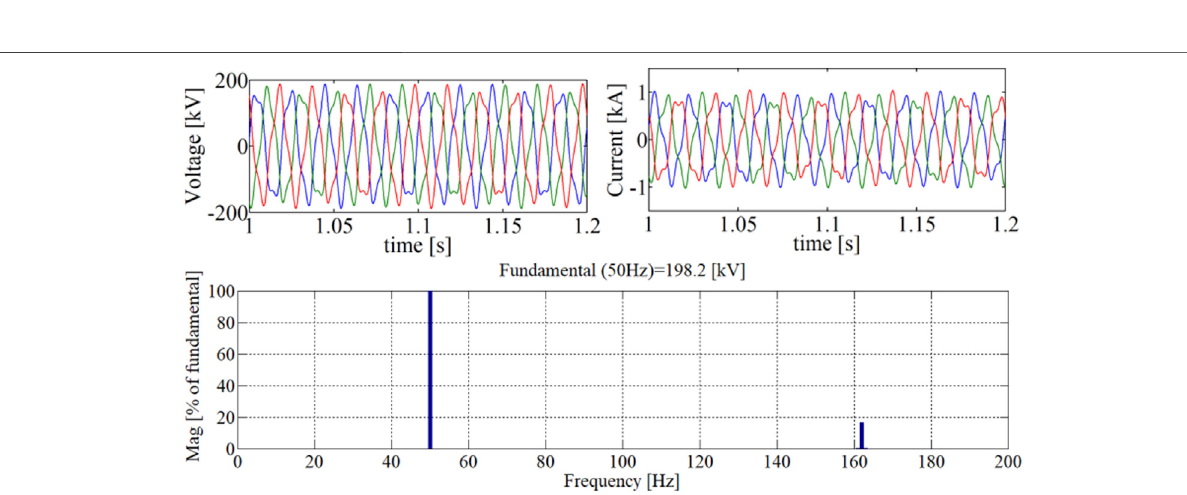
Frontiers in Energy Research |